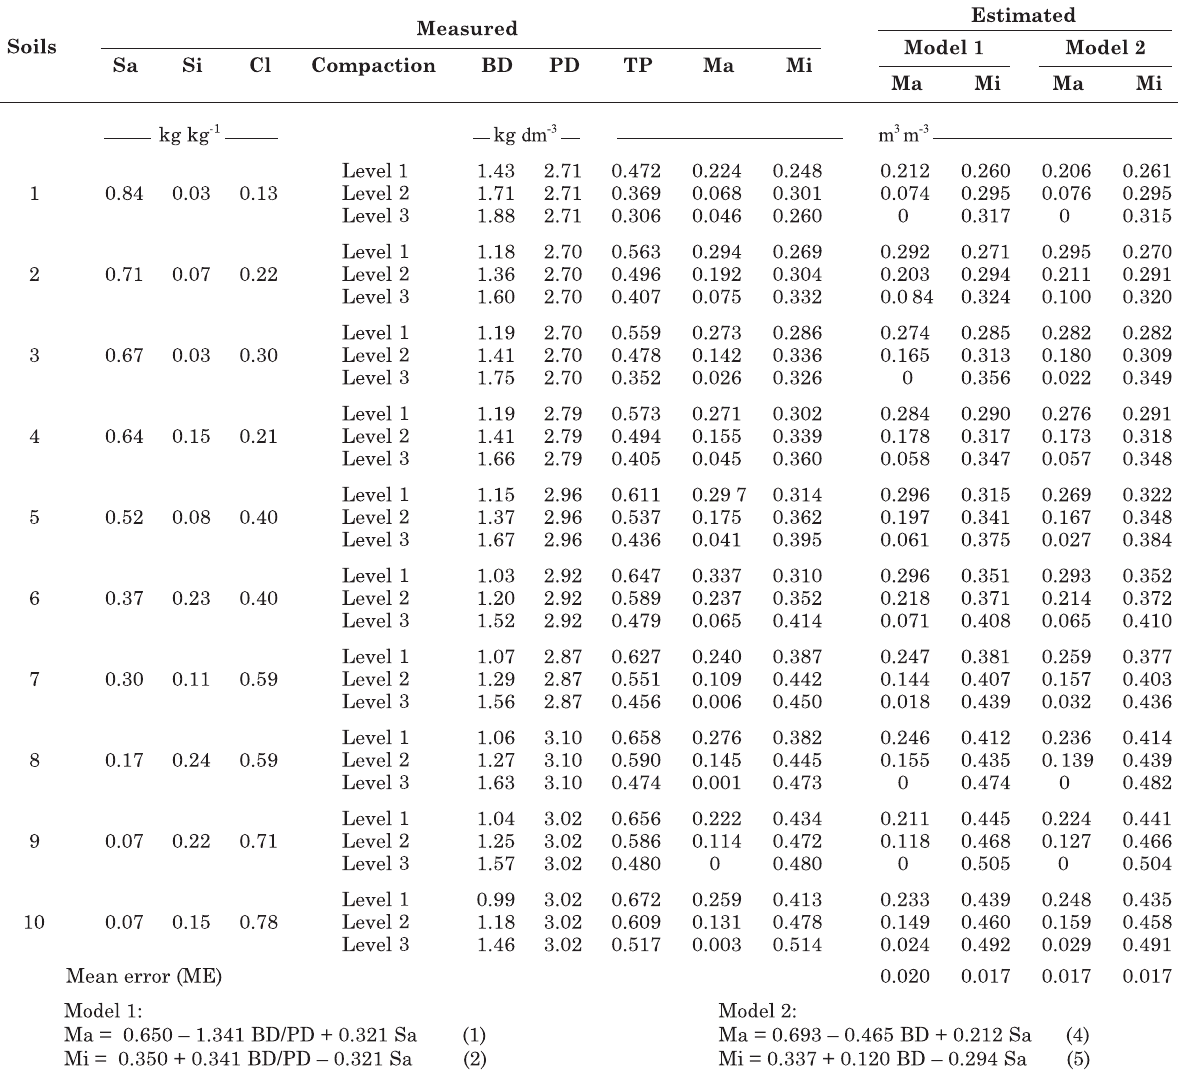
Table 2. Measured and estimated values of macro (Ma) and microporosity (Mi) and measured values of sand table 1, subjected to three compaction levels